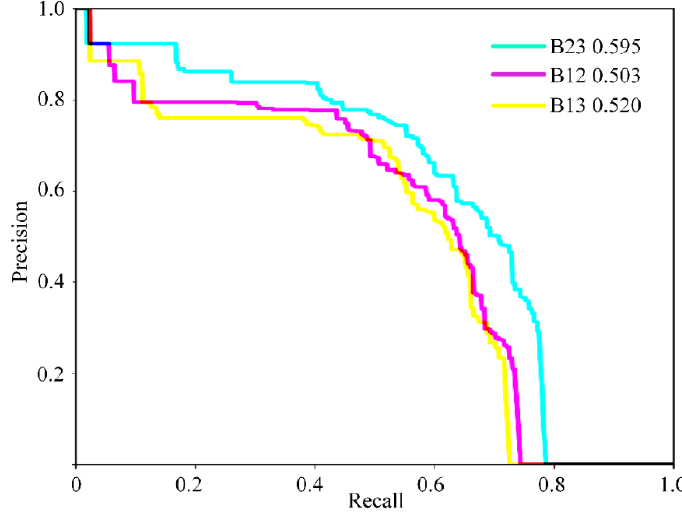
Figure 8. The Precision and Recall curve of combined bands B23, B12, and B13.